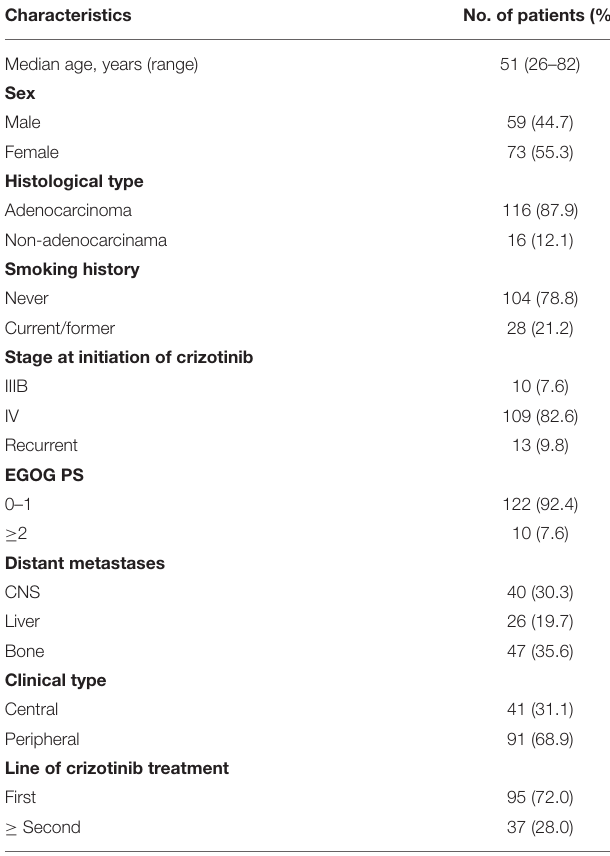
TABLE 1 | Baseline characteristics of the patients ( n =